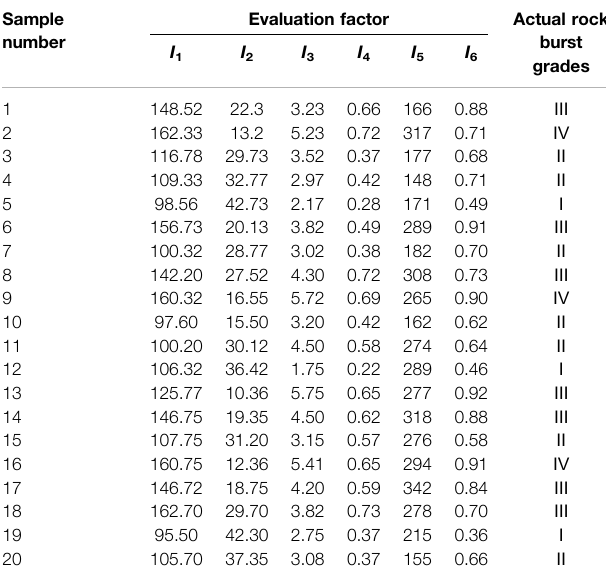
TABLE 3 | Measured rock burst index values and actual rock burst